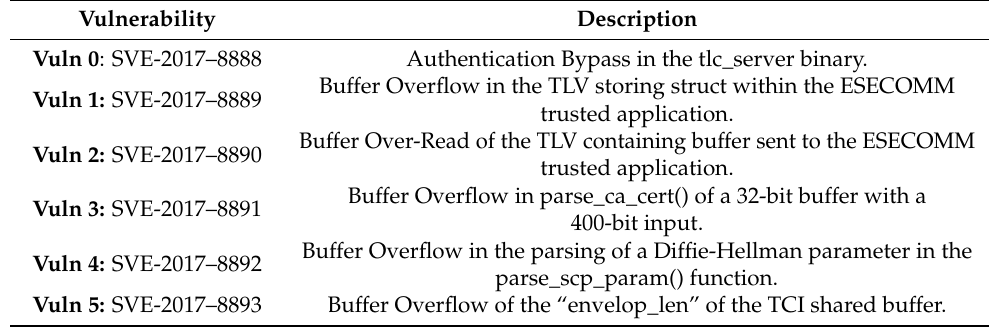
Table 1. Kinibi vulnerabilities of the unbox your phone attack reported as SVEs. Vulnerability